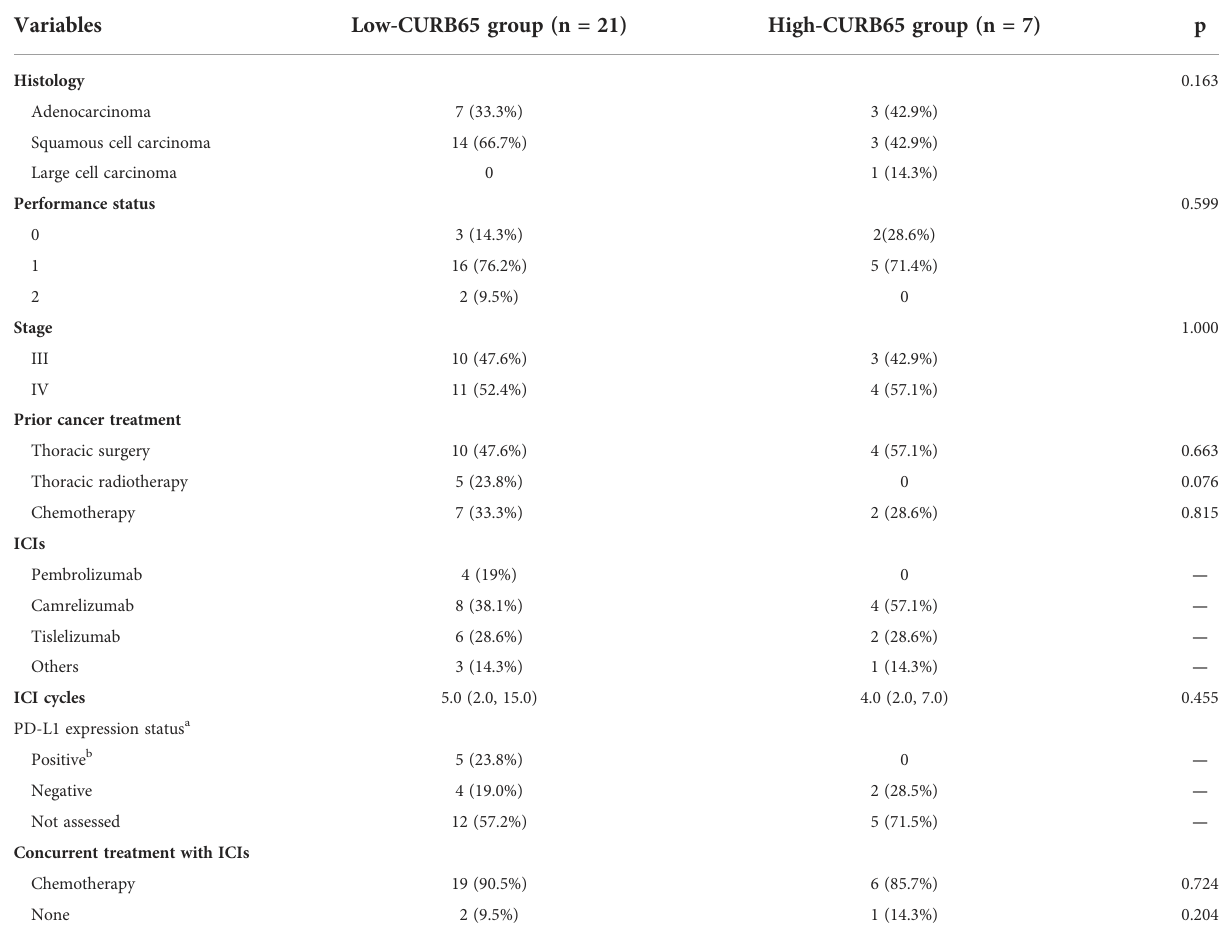
TABLE 2 Lung cancer history and ICI